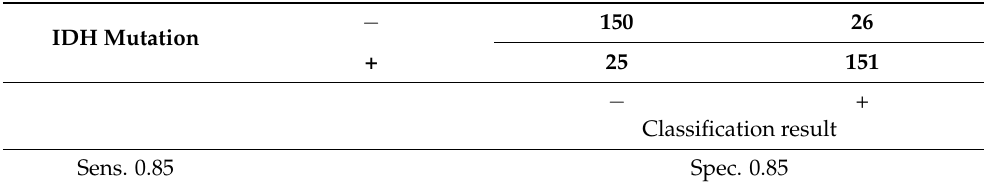
Table 1. Cross tabulation of the classification results